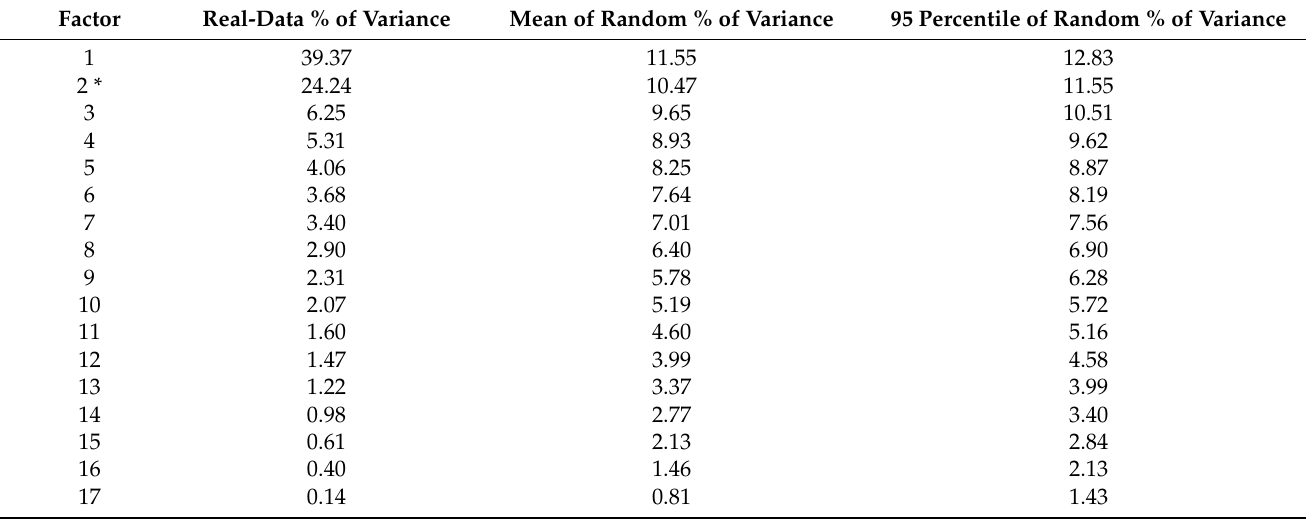
Table 2. Parallel analysis—minimum rank factor analysis (MRFA)